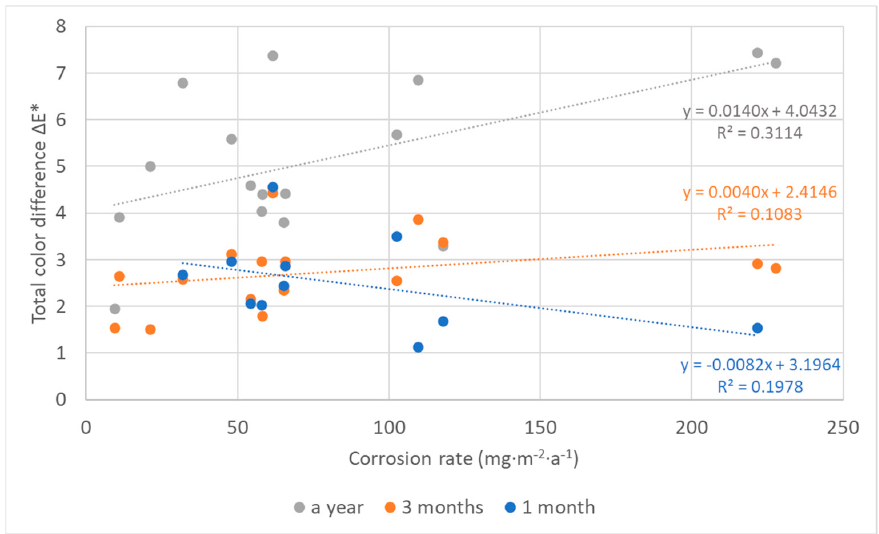
Figure 22. Comparison of corrosion rates of zinc based on mass losses after 1-year exposure with total color changes after 1, 3, and 12 months (location 18 was excluded).